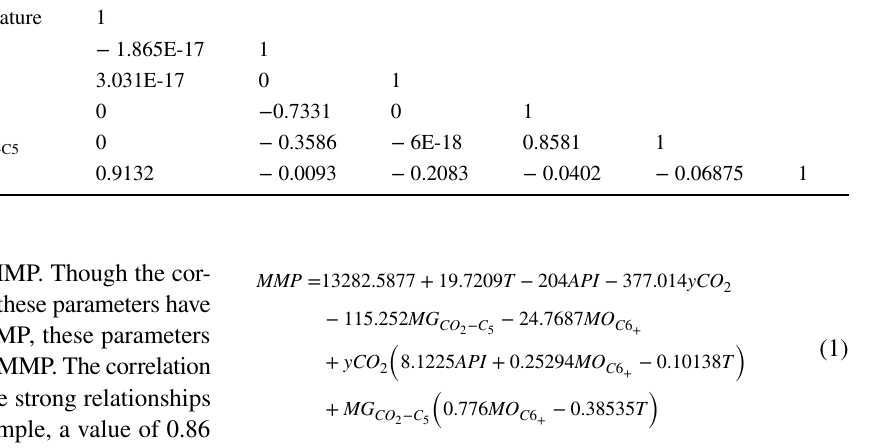
Table 3 Correlation coefficient analysis between independent and dependent